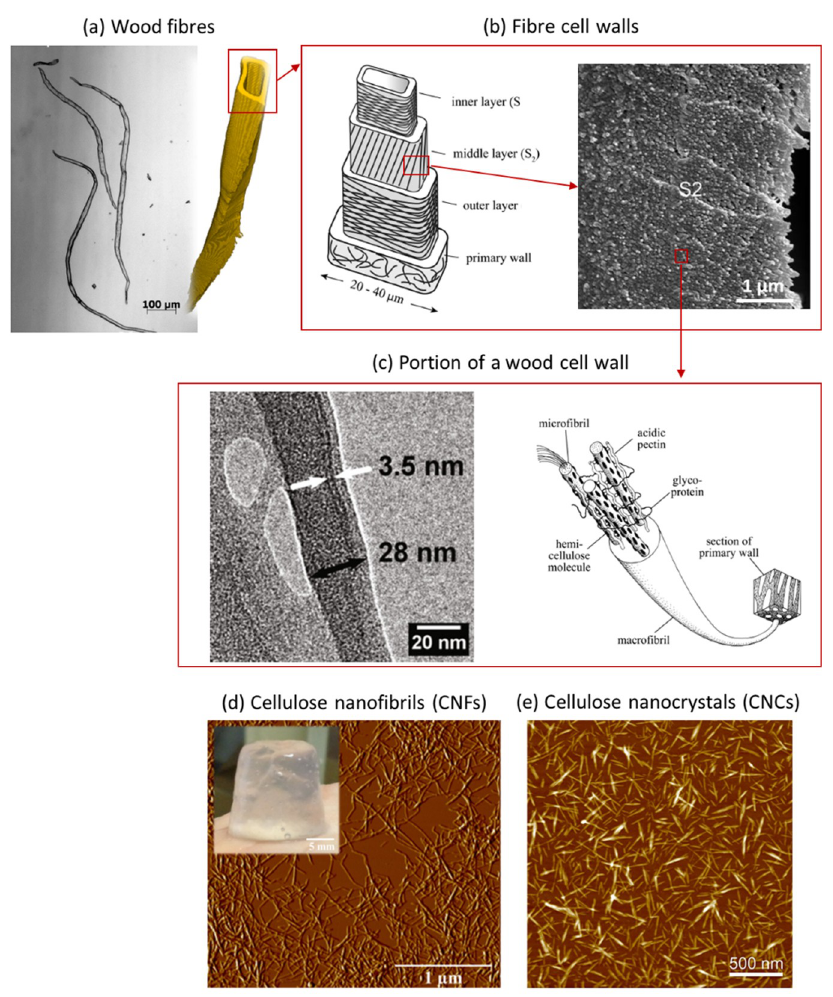
Figure 1. Hierarchical structure of wood fibres ( a ), showing the various layers (S1, S2, S3) in wood cell wall ( b ) [14] (Adapted from Donaldson [14] with permission from © Springer-Verlag 2007). ( c ) Portion of a wood cell wall showing the cellulose microfibrils aligned and bound in the form of bundles by hemicelluloses and lignin. (Adapted from Chinga-Carrasco [15] with permission from licensee Springer. 2011). Atomic Force Microscope (AFM) micrographs of CNFs ( d ) [16] and CNCs ( e ) (Adapted from Klemm et al. [5] with permission from Elsevier). In Figure ( d ), the photograph inset shows a TEMPO-oxidised CNF water suspension with solids content of 1 wt%. Note that the TEMPO-oxidation is a chemical pre-treatment used to improve the delamination of cellulose fibres. This pre-treatment leads to a regioselective oxidation of cellulose primary alcohol groups (–OH) at the surface of the fibrils into carboxylate ones (–COO − ). As such, negatively charged CNFs are more easily isolated from the fibre walls during the disintegration process [17,18].